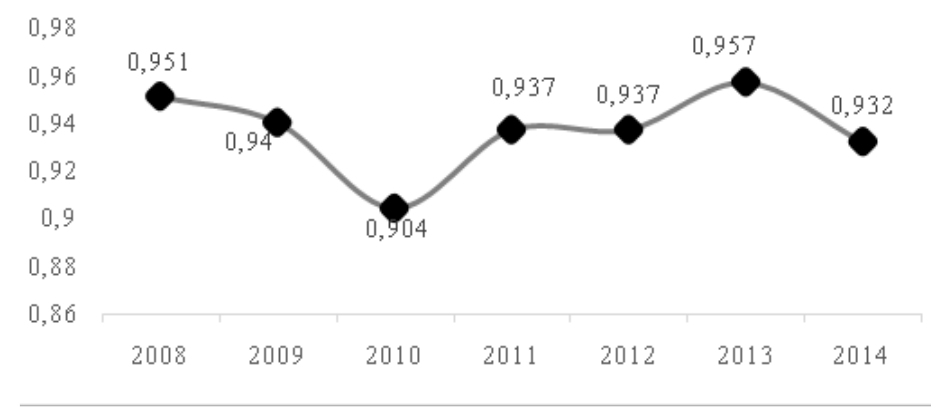
Figure 1: Development of Average Value of Industrial Technical Efficiency Year